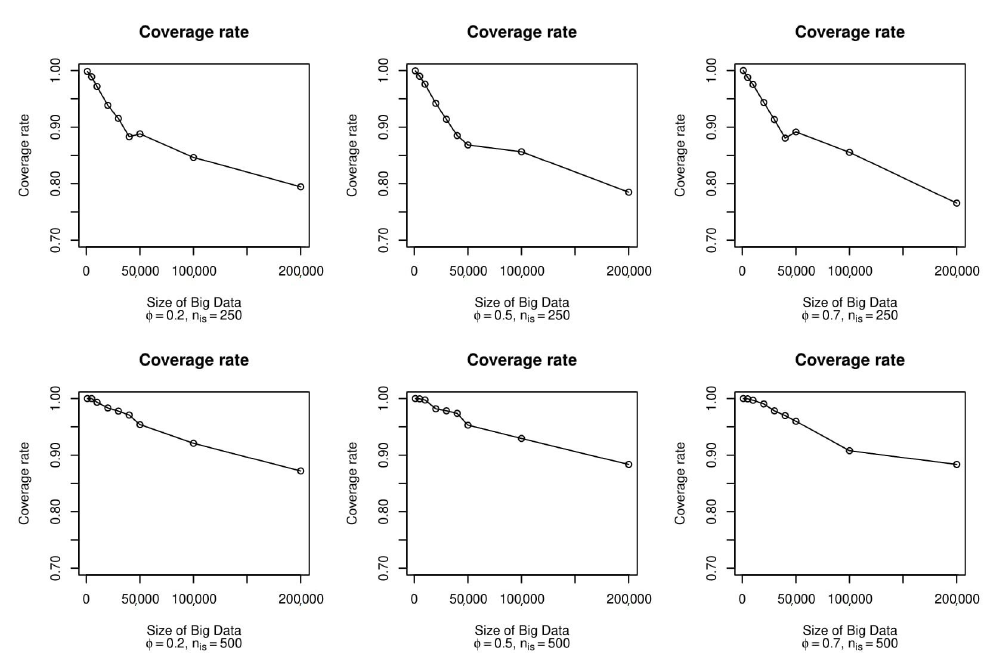
Figure 9. Coverage rate for the real case, according to the size of the big data, φ , and n is